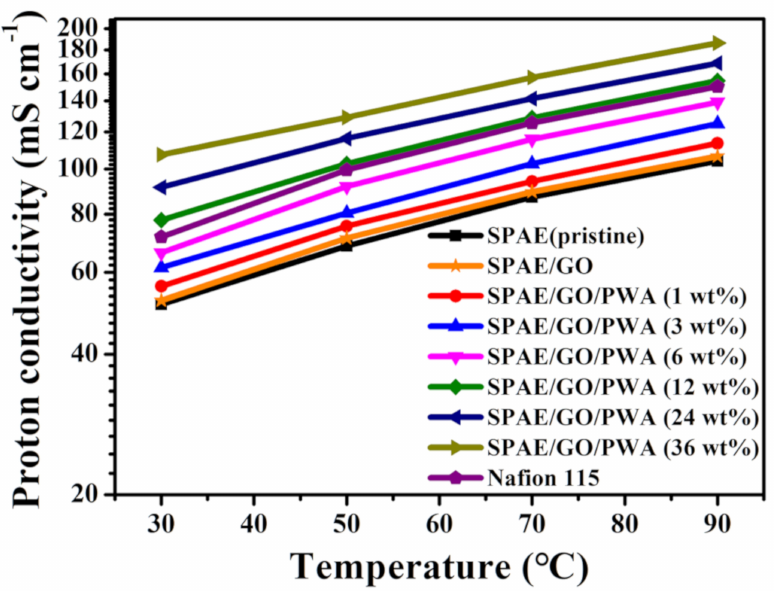
Figure 10. Proton conductivity of prepared membranes at various temperatures under 100% RH.